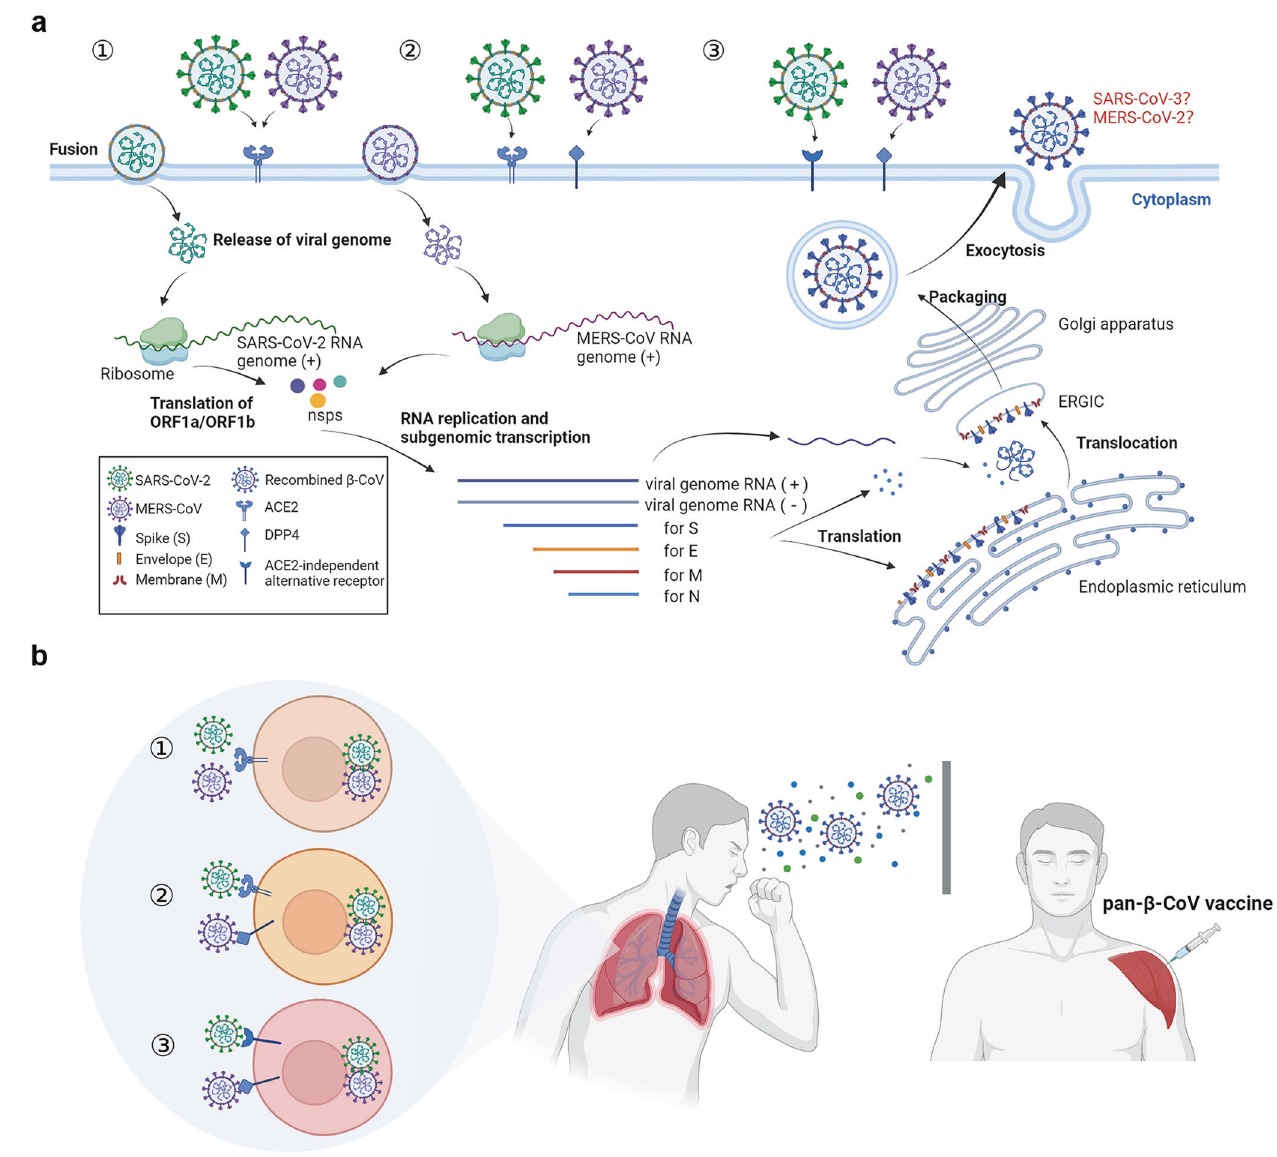
Fig. 1 Coinfection of SARS-CoV-2 and MERS-CoV may result in the emergence of recombined β -CoV, SARS-CoV-3, or MERS-CoV-2, thus calling for the development of pan-CoV vaccine. a Because of the identical infection cycle of SARS-CoV-2 and MERS-CoV, recombination may occur when ACE2-using MERS-CoV coinfect with SARS-CoV-2 in ACE2-expressing cells ① , or when SARS-CoV-2 and MERS-CoV coinfect a cell expressing both ACE2 and DPP4 ② , or when MERS-CoV coinfect with SARS-CoV-2 in the cells expressing DPP4 and one of the ACE2- independent alternative receptors (such as CD147, NRP1, ASGR1, KREMEN1, and AXL) ③ , resulting in an emerging β -CoV, SARS-CoV-3 or MERS- CoV-2, via genetic recombination between SARS-CoV-2 and MERS-CoV. ( b) SARS-CoV-2/MERS-CoV recombination calls for the development of a pan- β -CoV vaccine to prevent infection of the newly emerged β -CoV, SARS-CoV-3, or MERS-CoV-2. The illustration was created by the author (Lujia Sun) using BioRender program